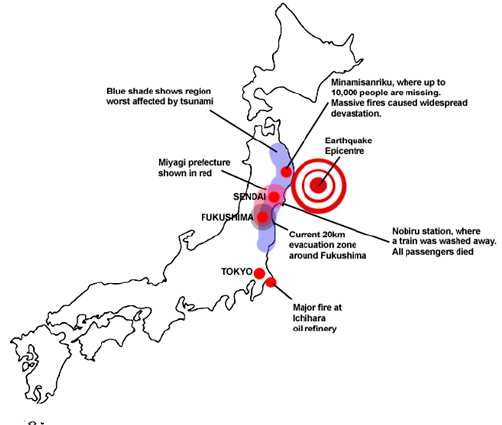
Figure 2. Map of Tohoku earthquake zones (source: Figure 2. MapofTohokuearthquakezones(source: https: // 100gf.files.wordpress.com / 2011 / 03 / https://100gf.files.wordpress.com/2011/03/japanmap.gif).